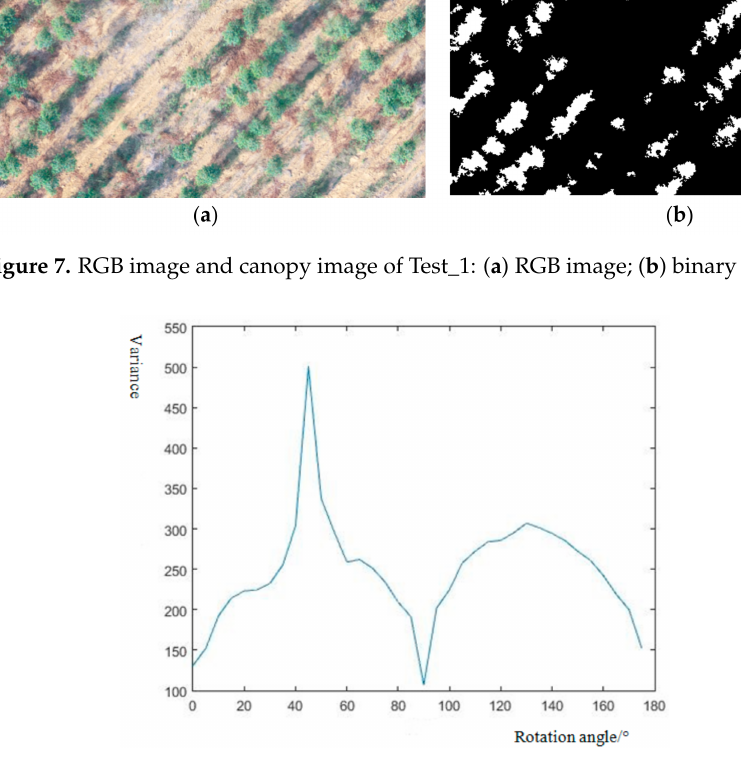
Figure 8. Distribution of S 2 with L = 0.6 G.